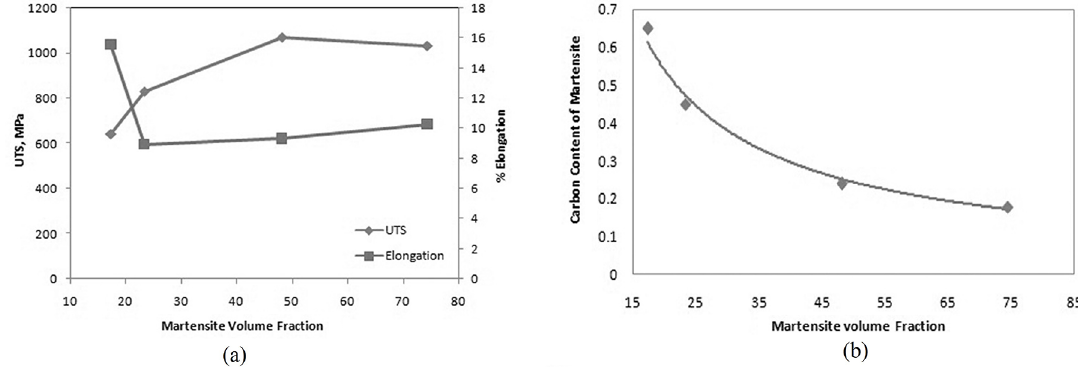
Figure 6. (a) The variation of UTS and elongation as a function of martensite volume fraction, (b) The variation of carbon content of martensite as a function of martensite volume fraction.